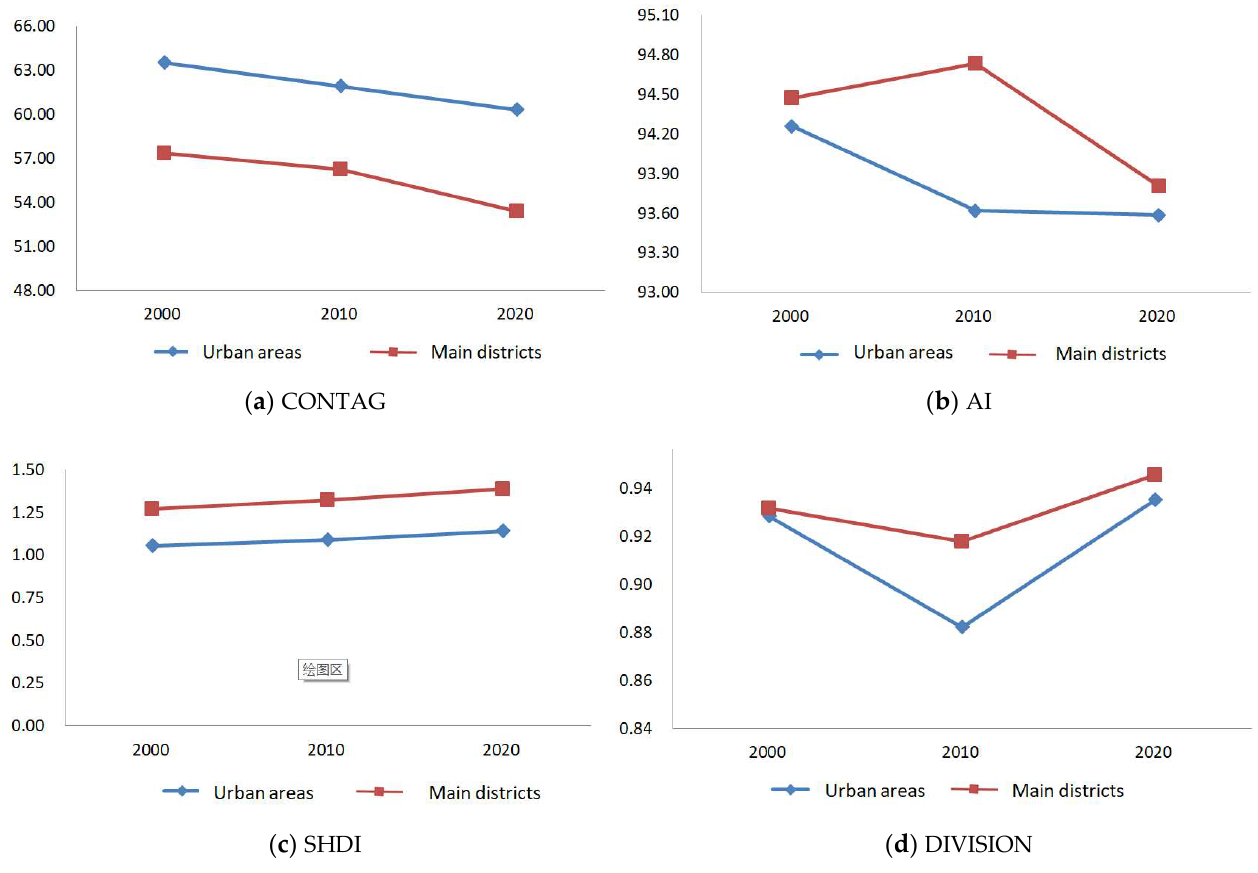
Figure 4. Evolution of landscape index at the landscape level.